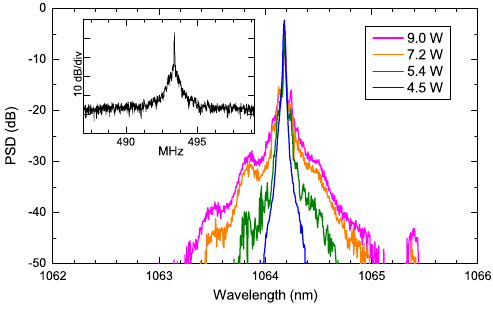
Figure 8: Experimental spectra for off-phase-matched SHG in lithium tantalate crystal at a temperature of 39.0 ∘ C for different input pump powers. The inset shows the beat note of the infrared radiation at 493